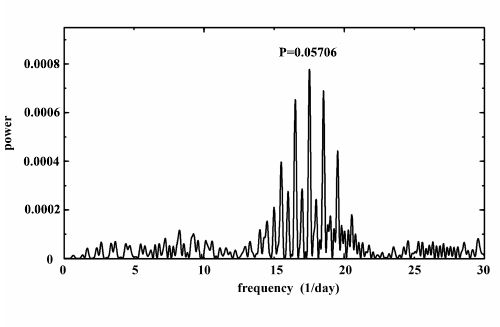
Figure 7: The power spectrum of J2051.